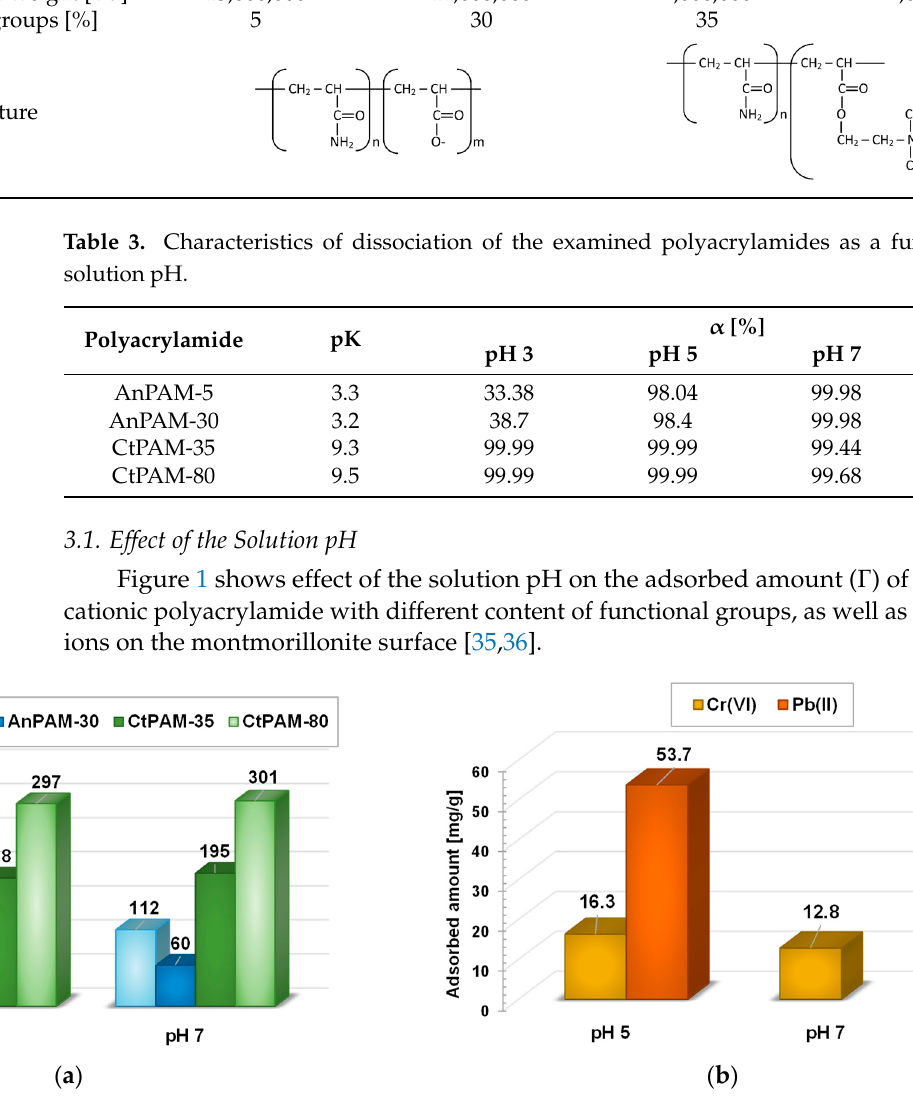
Figure 1. Adsorbed amounts of: ( a ) ionic PAMs; ( b ) heavy metal ions on the montmorillonite surface at pH 5 and 7; initial concentration of adsorbates is 100 mg/L. at pH 5 and 7; initial concentration of adsorbates is 100